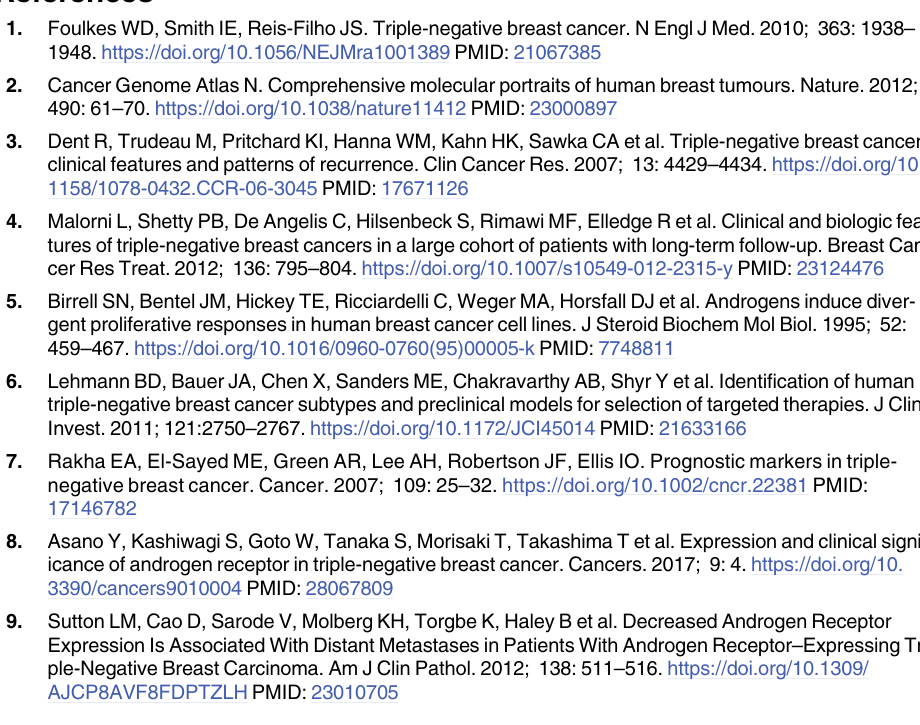
using � 10% for max